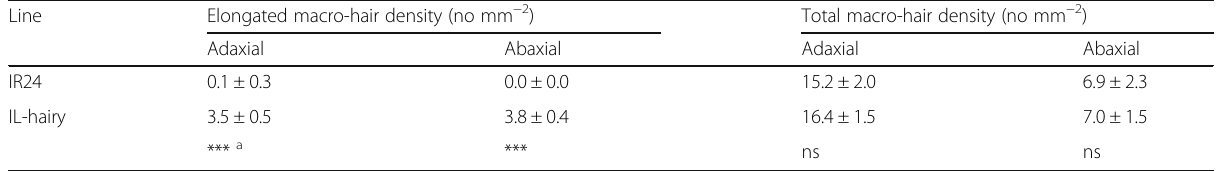
Table 1 Elongated macro-hair density and total macro-hair (sum of elongated and short types of macro-hair) density of leaves in IR24 and IL-hairy at the tillering stage Line Elongated macro-hair density (no mm − 2 ) Total macro-hair density (no mm − 2 ) Adaxial Abaxial Adaxial Abaxial IR24 0.1 ± 0.3 0.0 ± 0.0 15.2 ± 2.0 6.9 ± 2.3 IL-hairy 3.5 ± 0.5 3.8 ± 0.4 16.4 ± 1.5 7.0 ± 1.5 *** a *** ns ns Data are means±SD ( n =4). a *** P =0.01; ns, not significant by Student ’ s t -test at P